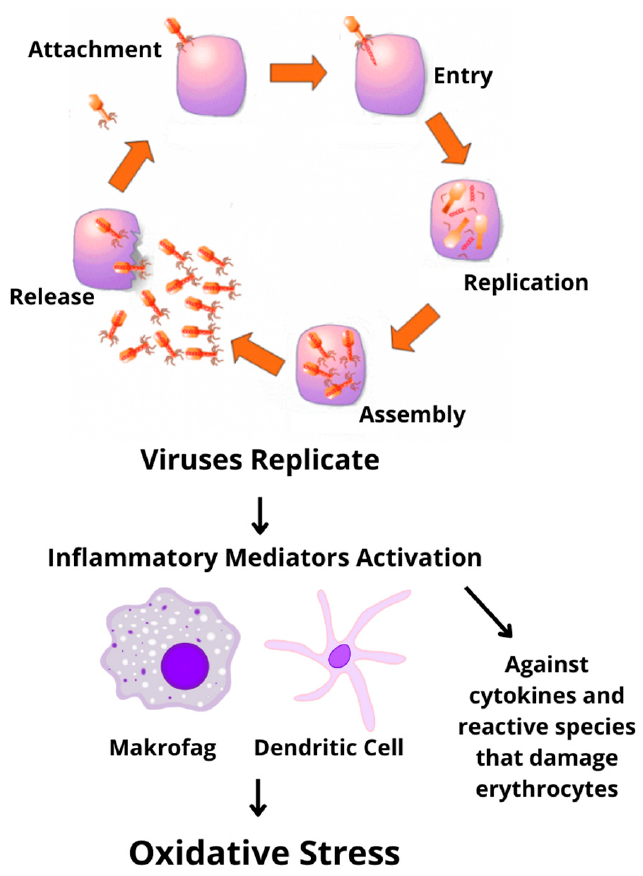
Figure 6. Cytokine expression via the NF- κβ pathway causes a cytokine storm.